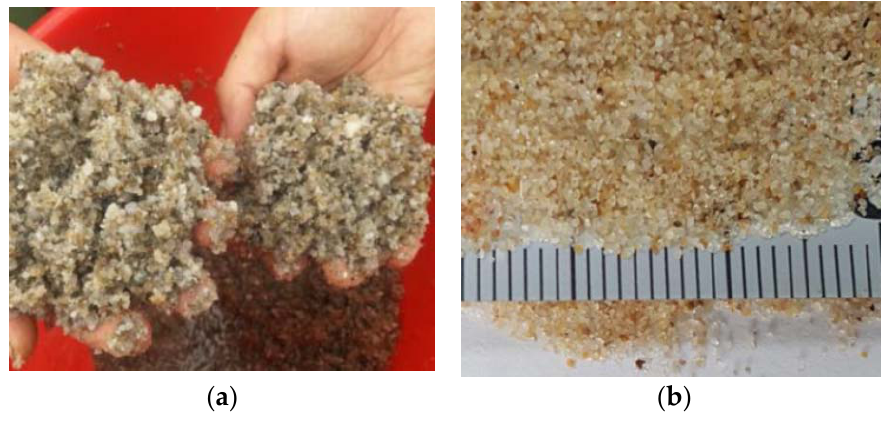
Figure 6. ( a ) Dredged sediment before sieving. ( b ) Dredged sediment after sieving.